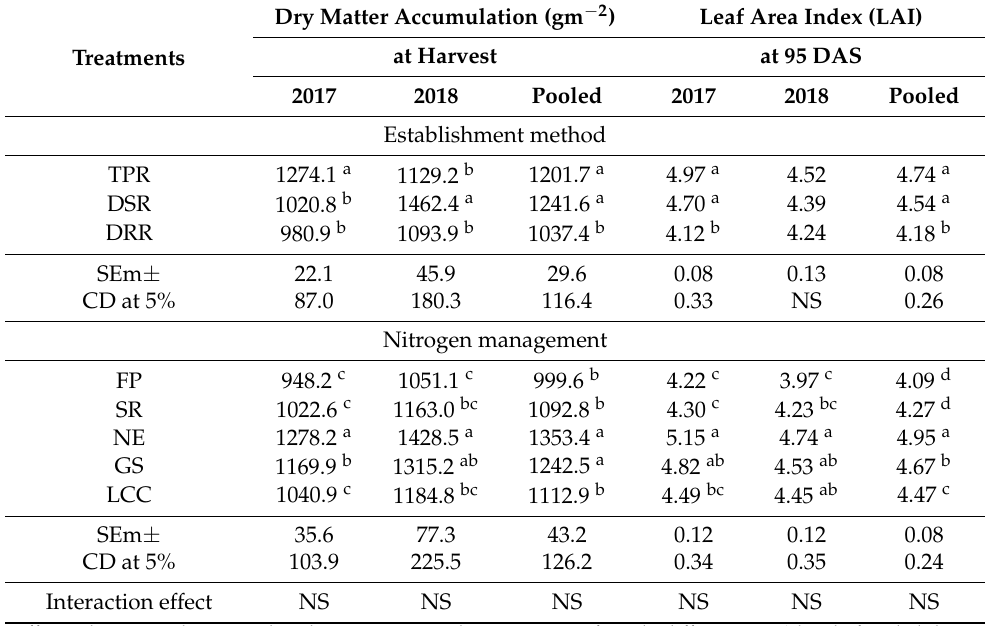
Table 4. Influence of crop establishment method and nitrogen management on dry matter